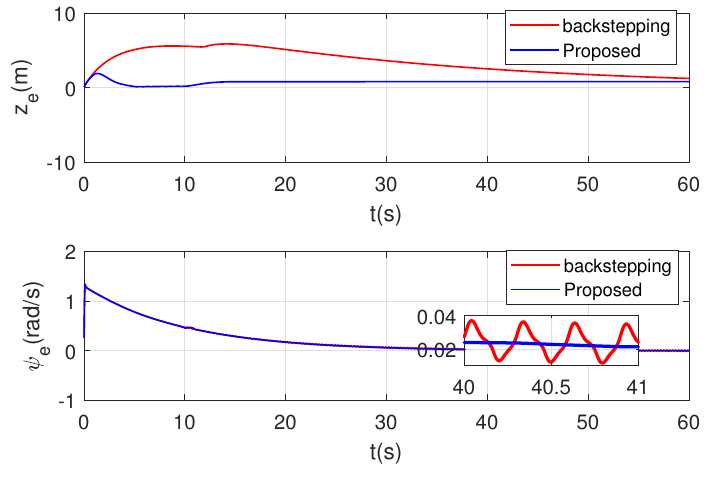
Figure 6. Tracking